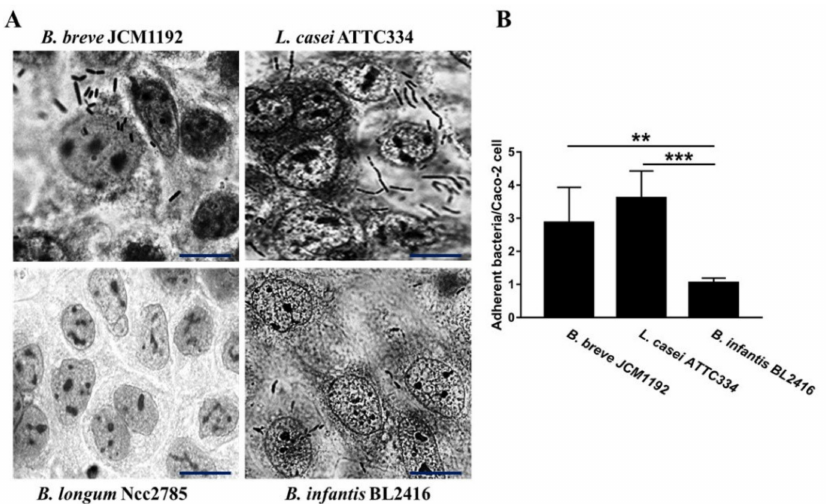
Figure 1. Comparison of different probiotics interactions with Caco-2. ( A ) Images acquired using a phase contrast microscopy showing the adherence of bacterial strains to Caco-2 cells. Confluent monolayers of the Caco-2 cells were challenged with B. breve JCM1192, L. casei ATTC334, B. longum Ncc2785 or B. nfantis BL2416 strains at a multiplicity of infection of ~100 (bacteria to epithelial cell) for 60 min. The cells were washed 3 times with PBS, fixed with methanol and stained with Giemsa stain. [Scale bar = 20 µ m] ( B ) A total of 100 cells were examined under the light microscope and the number of bacteria adhered L. casei ATTC334, infantis BL2416 cells per Caco-2 cell were 2.9 ± 1.1, 3.6 ± 0.8 and 1.05 ± 0.1 (nucleus ± SD)